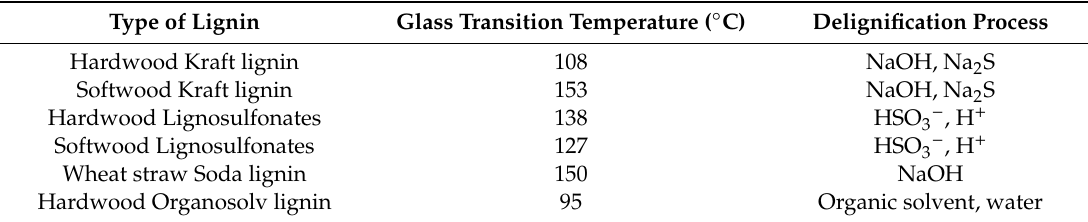
Table 2. Glass transition temperature and delignification process of di ff erent lignins [53,60,61]. Type of Lignin Glass Transition Temperature ( ◦ C) Delignification Process Hardwood Kraft lignin 108 NaOH, Na 2 S Softwood Kraft lignin 153 NaOH, Na 2 S Hardwood Lignosulfonates 138 HSO 3 − , H + Softwood Lignosulfonates 127 HSO 3 − , H + Wheat straw Soda lignin 150 NaOH Hardwood Organosolv lignin 95 Organic solvent,